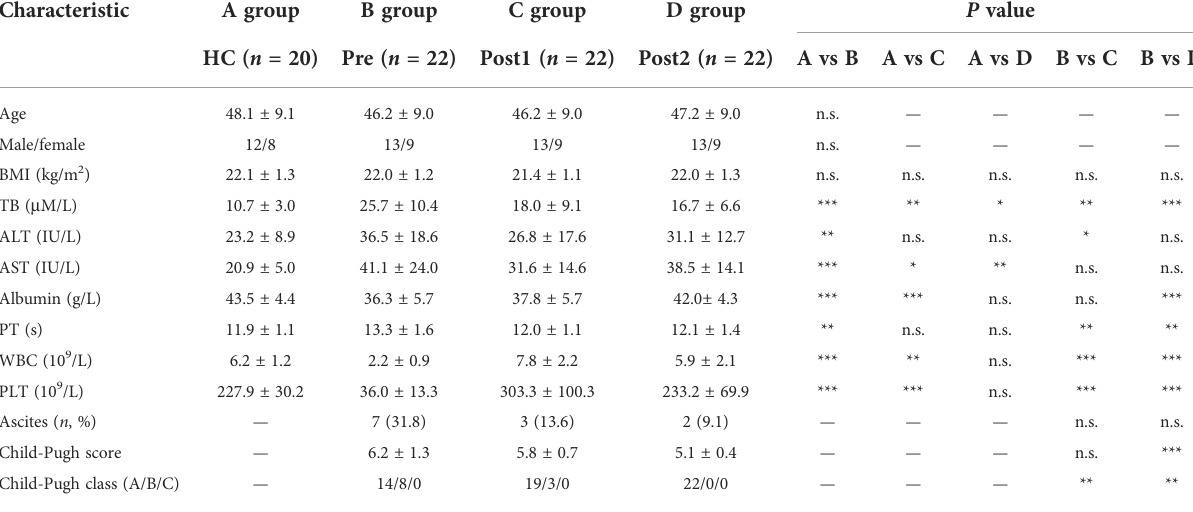
TABLE 1 Clinical information summary of cirrhotic patients and healthy